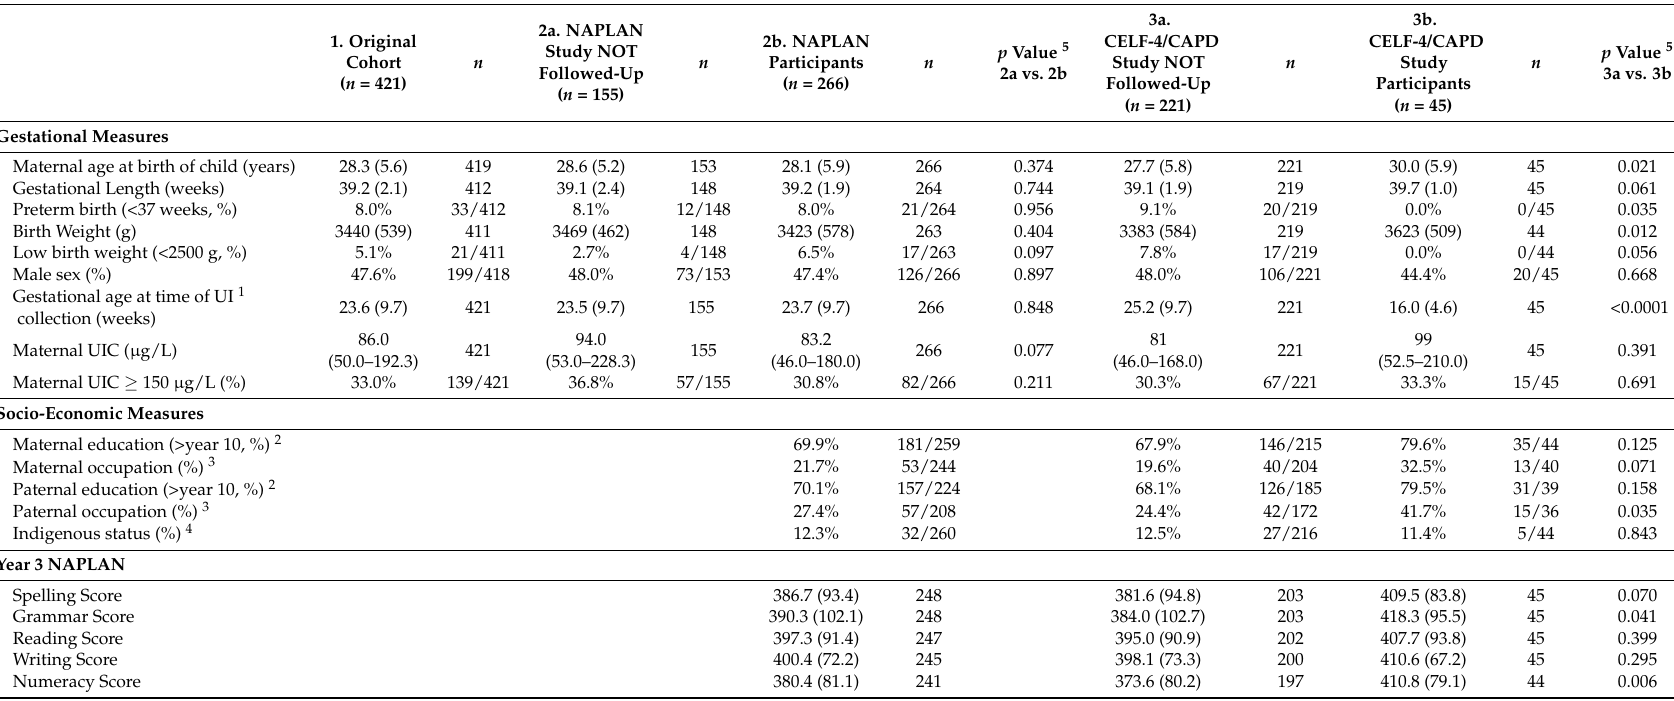
Table 1. Characteristic comparisons of participants and non-participants: Original birth cohort ( n = 421), National Assessment Program–Literacy and Numeracy (NAPLAN) Study ( n = 266) and Comprehensive Evaluation of Language Fundamentals (CELF-4) and Central Auditory Processing Disorder (CAPD) Study ( n =